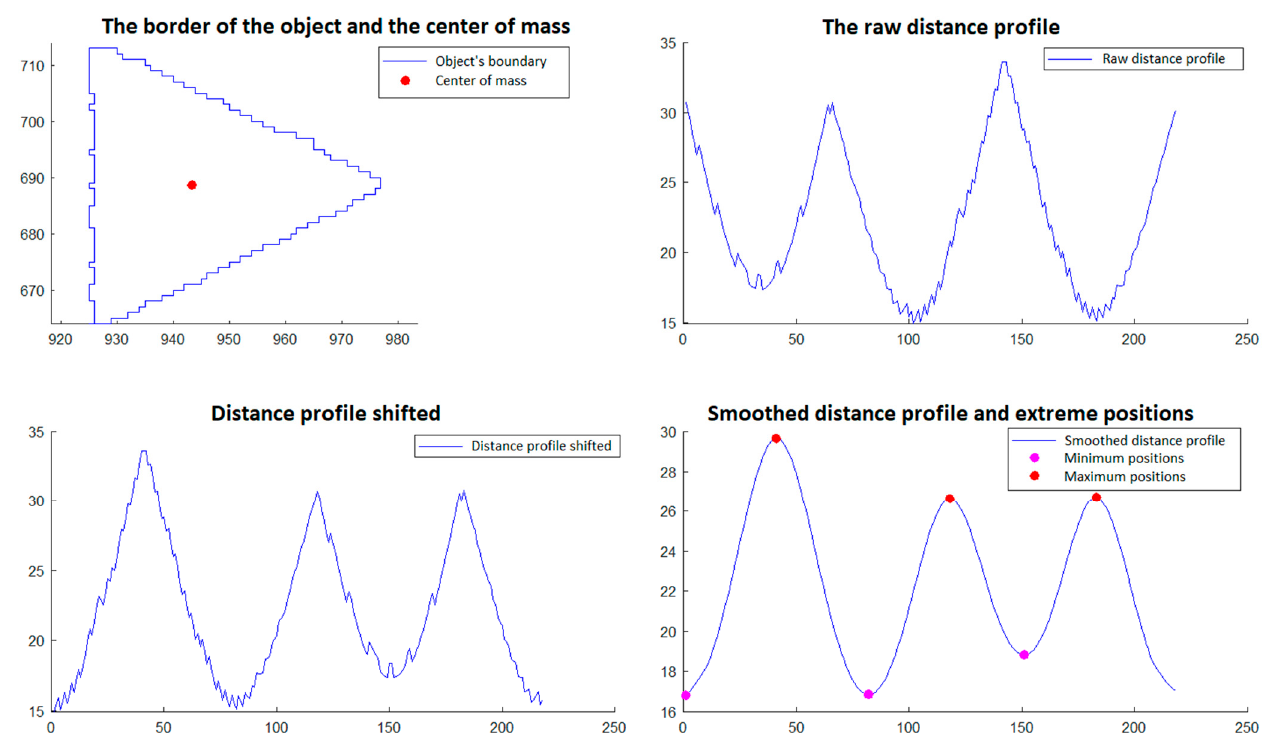
Figure 13. Triangular object selection procedure (step 5)—East triangular object.